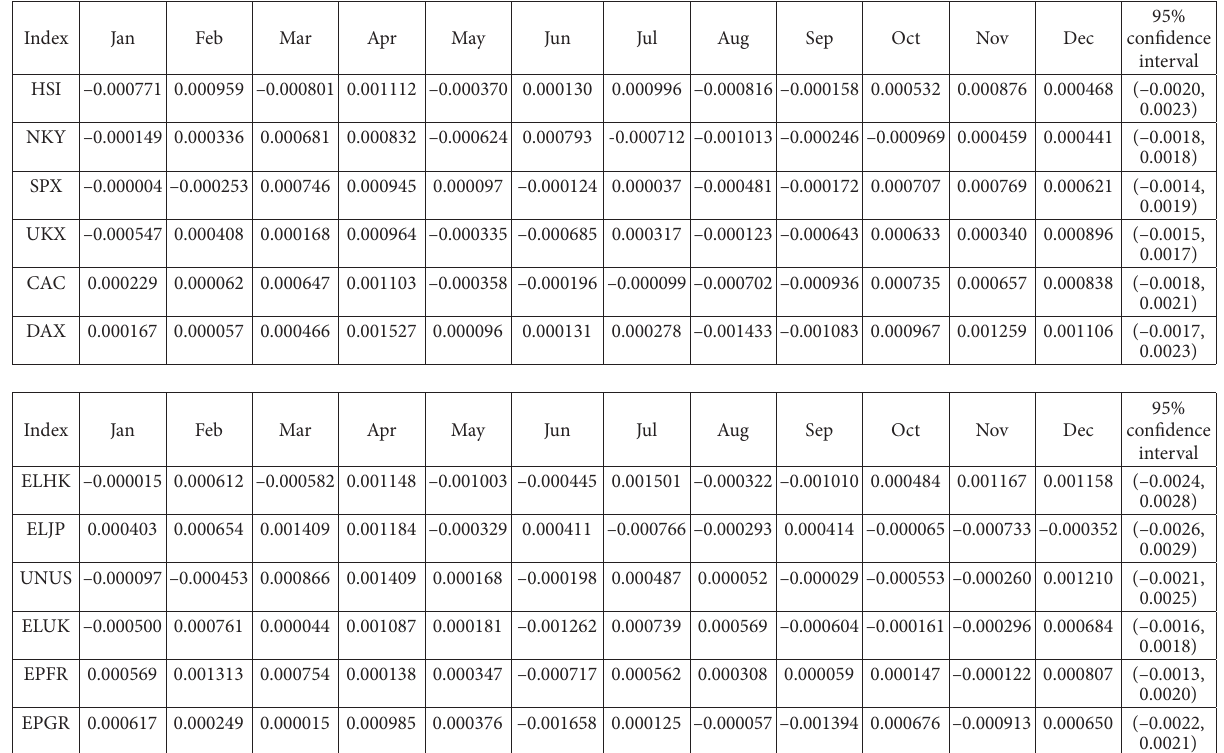
Table 4. The test results for the overall calendar effect using the normal method